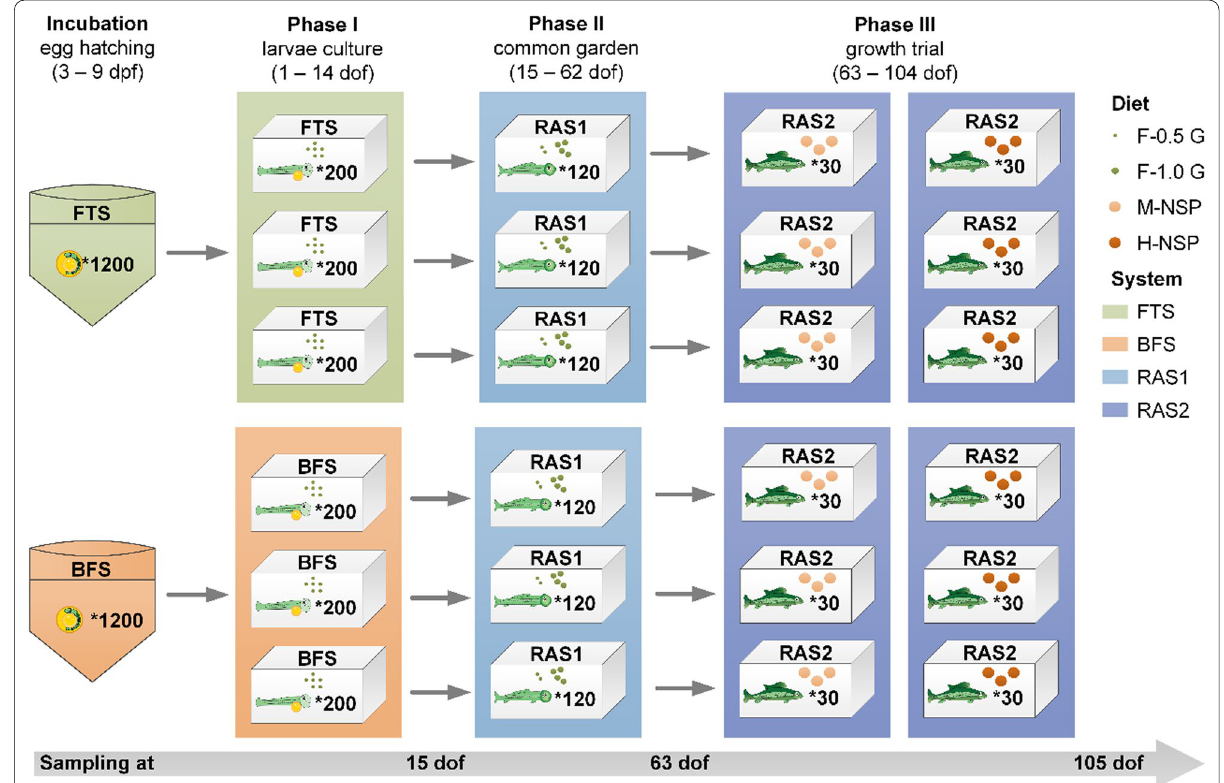
Fig. 1 Schematic illustration of the experimental design and fish sampling. FTS flow-through system, BFS biofloc system, RAS recirculating aquaculture system, M-NSP moderate non-starch polysaccharide (NSP) diet, H-NSP high NSP diet, dpf days post fertilisation, dof days of